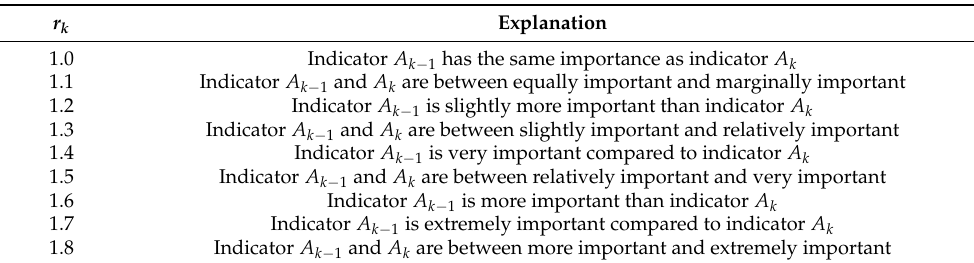
Table 2. Relative importance of two adjacent